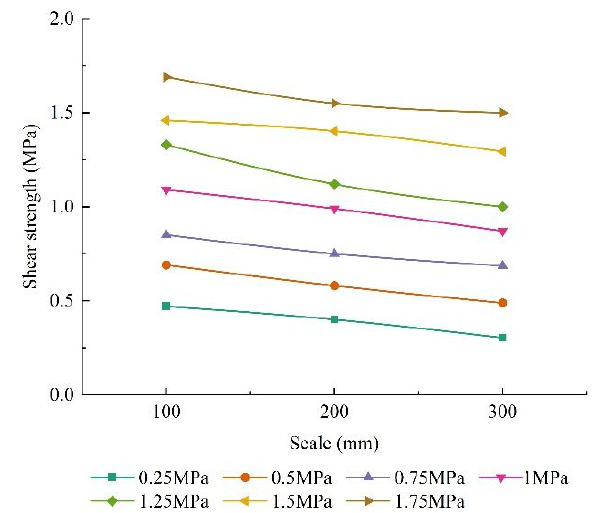
Figure 18: Relationship between shear strength and scale